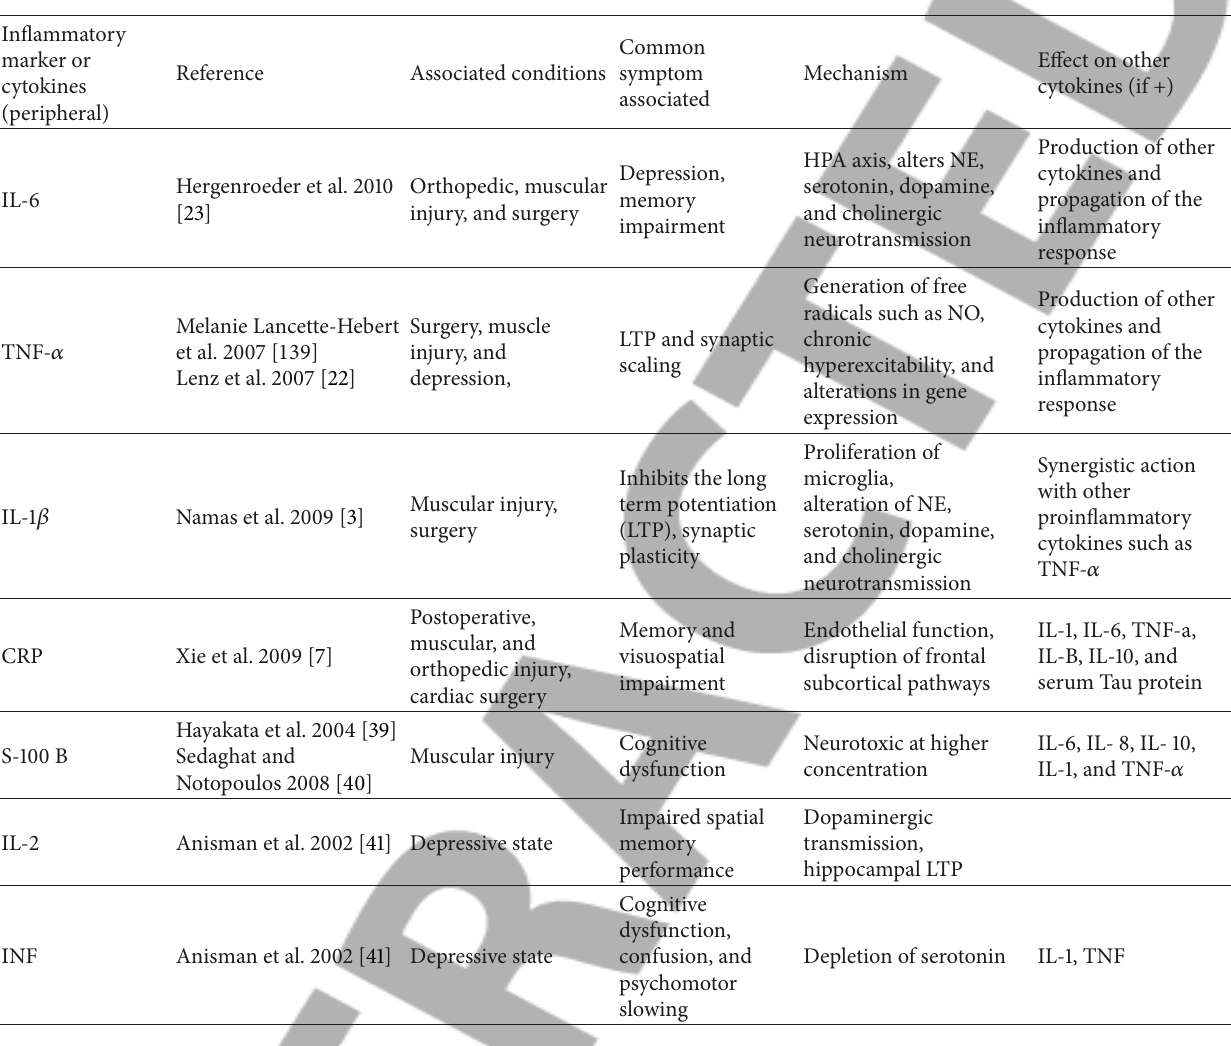
Table 2: The overview of common but important inflammatory markers involved in systemic inflammatory response and neurocognitive